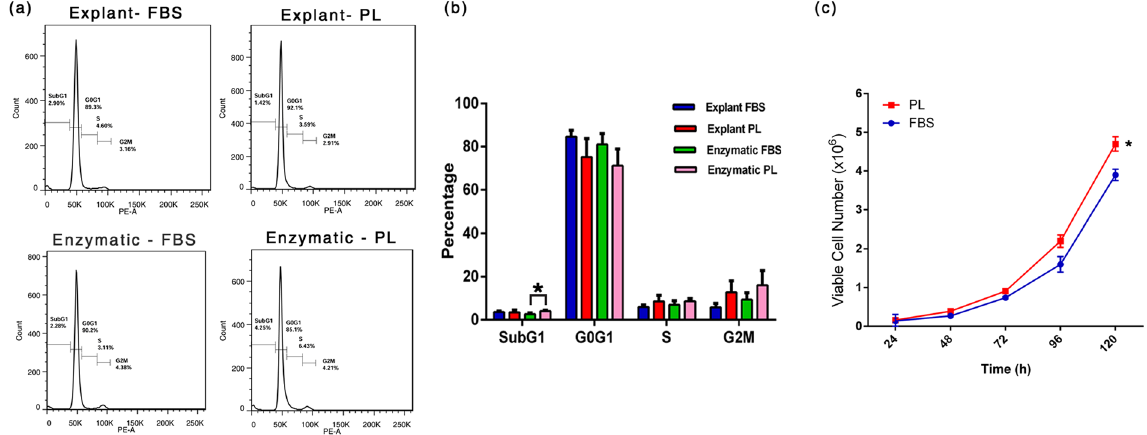
Figure 5. Cell cycle analysis and growth kinetics. ( a ) Representative histograms of cell cycle in synchronized MSCs ( b ) DNA contents according to the cell cycle phase G0/G1 phase, S phase and G2/M phase for PL and FBS supplemented MSC cultures. Data are represented as mean of three independent experiments. Paired one tailed student’s t test for SubG1 phase of enzymatic cultures was P = 0.02. ( c ) Growth rate of UCT-MSC cultured in PL was significantly higher than those in FBS on day 5 by trypan blue dye exclusion (P = 0.05). * P ≤ 0.05.